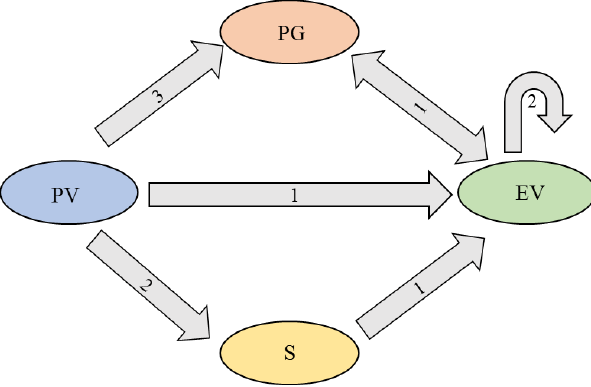
Figure 2. DC microgrid power flow. PG: public grid, S: storage system